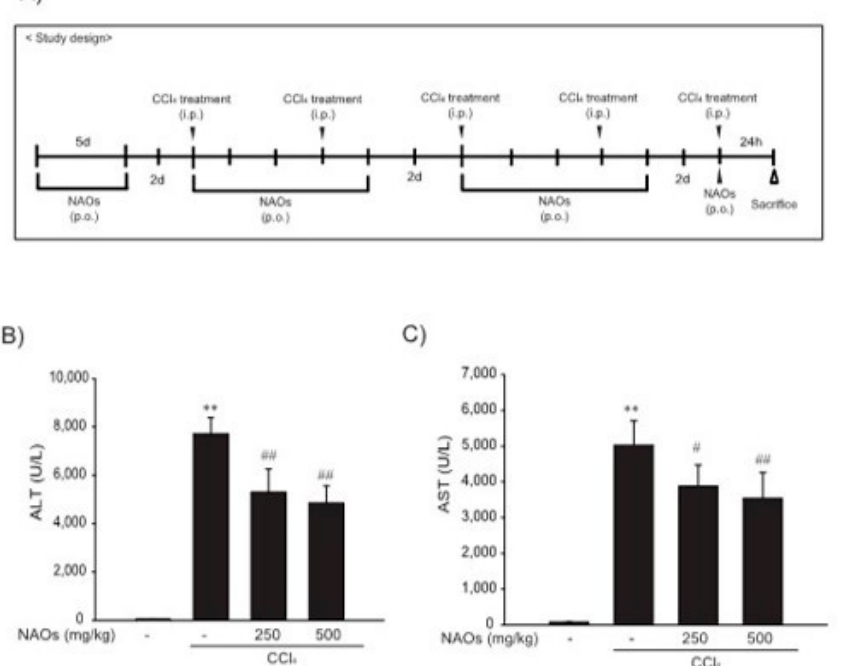
Figure 3. Inhibition of CCl 4 -induced liver injury by neoagarooligosaccharides (NAOs). ( A ) Study design. Prior to CCl 4 treatment to induce liver fibrosis, mice are treated with NAOs for 5 days. Liver fibrosis is then induced by intraperitoneal injection of CCl 4 (0.5 mg/kg, dissolved in olive oil [10%]) into mice, twice a week for 2 weeks. Mice are also treated with NAOs five times a week for two weeks. Twenty-four hours prior to sacrifice, mice are induced with a final intraperitoneal injection of CCl 4 . ( B , C ) Activities of serum alanine aminotransferase (ALT) and aspartate aminotransferase (AST) analyzed using an automated blood chemistry analyzer. All values are expressed as mean ± S.E. of five mouse serum samples (** p < 0.01, vs. vehicle control; ## p < 0.01, # p < 0.05, significant vs. CCl 4 ).